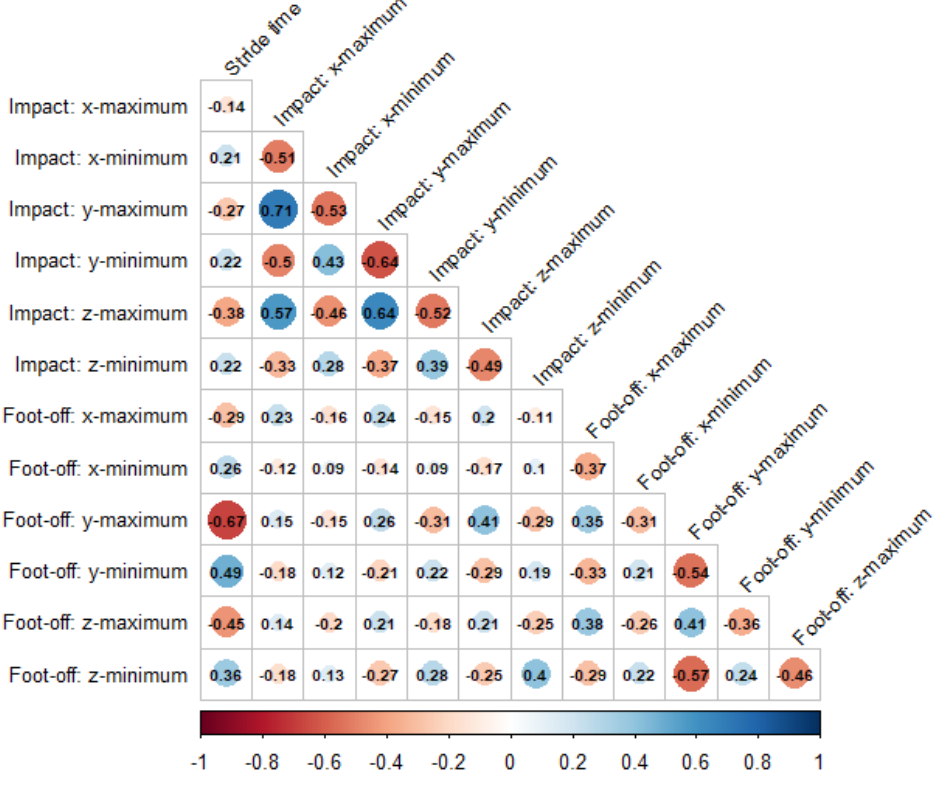
Figure A3. Correlation matrix outlining the Pearson Product Moment Correlation Coefficient amongst minimum and maximum acceleration parameters. All data are included here from all limbs.